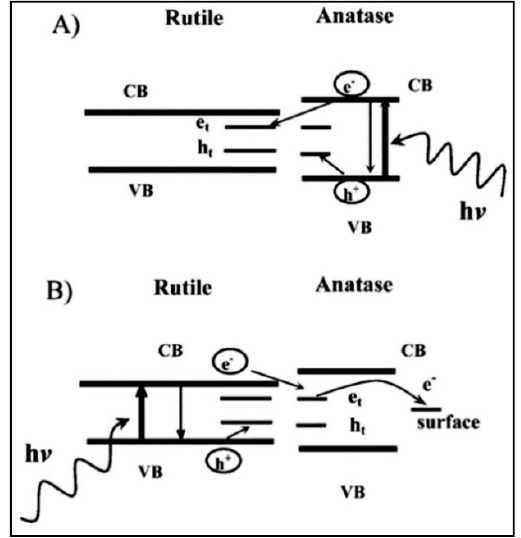
Figure 9. ( A ) Conventional model of P25 activity where charge separation occurs on anatase while rutile acts as electrons sink. ( B ) Proposed model of a rutile antenna and subsequent charge separation. Reprinted with permission from reference [191]. Copyright 1990 American Chemical Society.